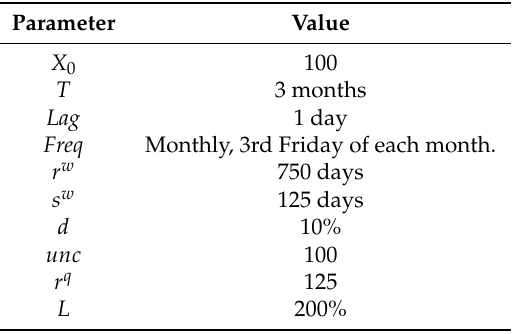
Table 2. Parameters used in the implementation of BL and NL as defined in the